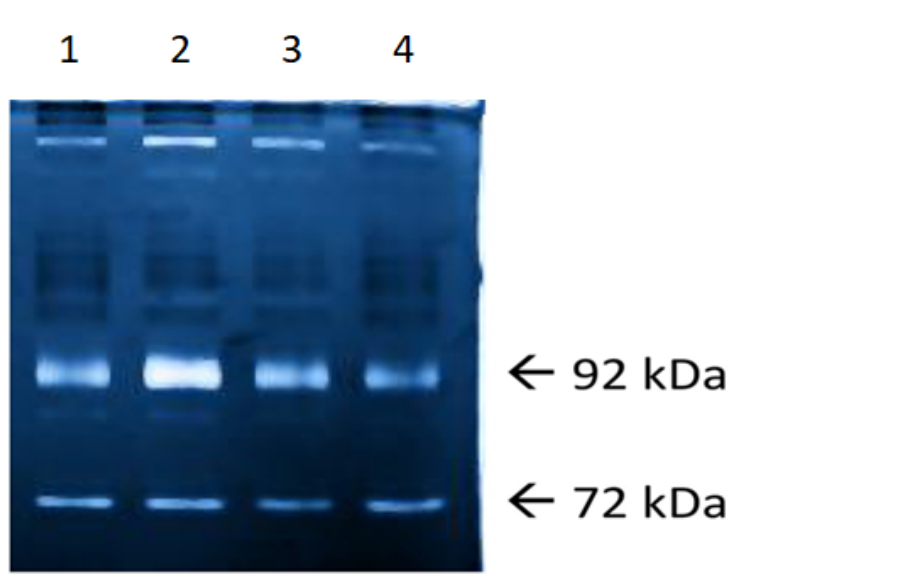
Figure 1. MMP-2, 72 kDa and MMP-9, 92 kDa in the next stages of research (1, 24 h before surgery; 2, 8 h post-surgery; 3, 24 h post-surgery; and 4, 48 h post-surgery).